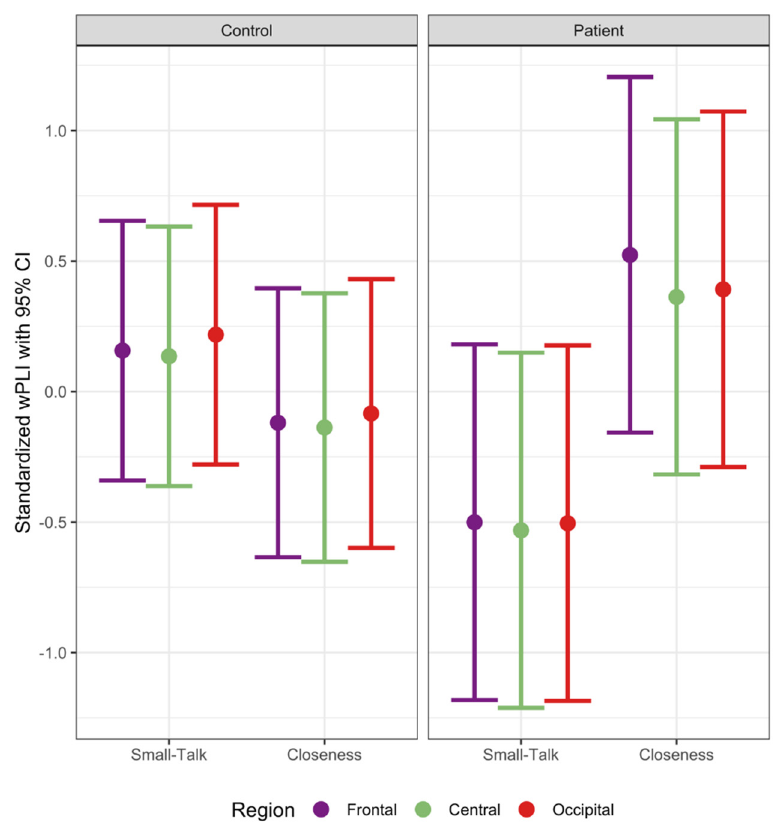
Figure 2. Alpha connectivity strength. Table 3. Standardized simple slope (standard error) estimates for the association of functional connectivity with symptom and post-interaction ratings in